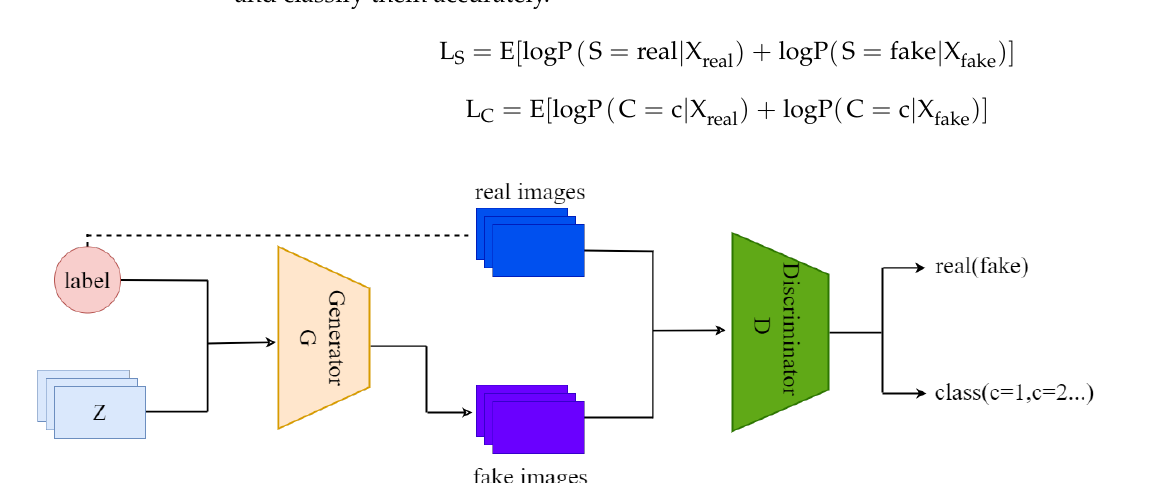
Figure 1. The model framework of conditional image synthesis with auxiliary classifier GANS.